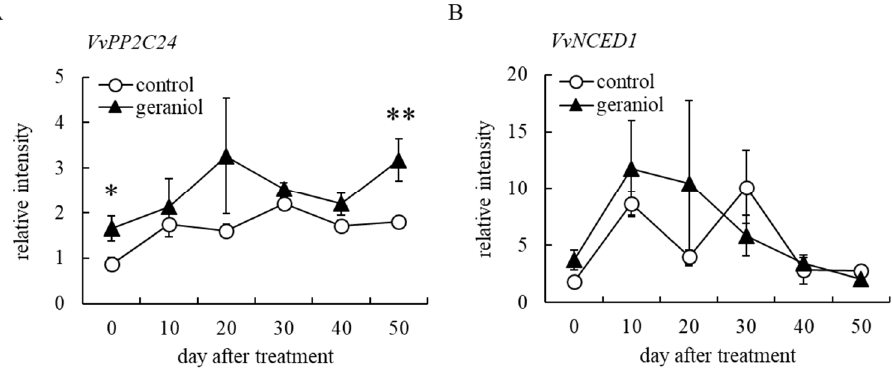
Figure 6. Effect of geraniol on VvPP2C24 and VvNCED1 transcription in grape berry skins. ( A ) Tran- scription levels of VvPP2C24 in berry skins. ( B ) Transcription levels of VvNCED1 in berry skins. The transcription levels in berry skins collected from geraniol-treated or control bunches of field-grown grapevines were estimated by real-time RT-PCR. Data were calculated as gene expression relative to β -actin expression. Bars indicate means ± standard errors for four bunches. * p < 0.05, ** p < 0.01 compared with control. Geraniol, treated with 10 nM geraniol. Control, treated with diluted ethanol.